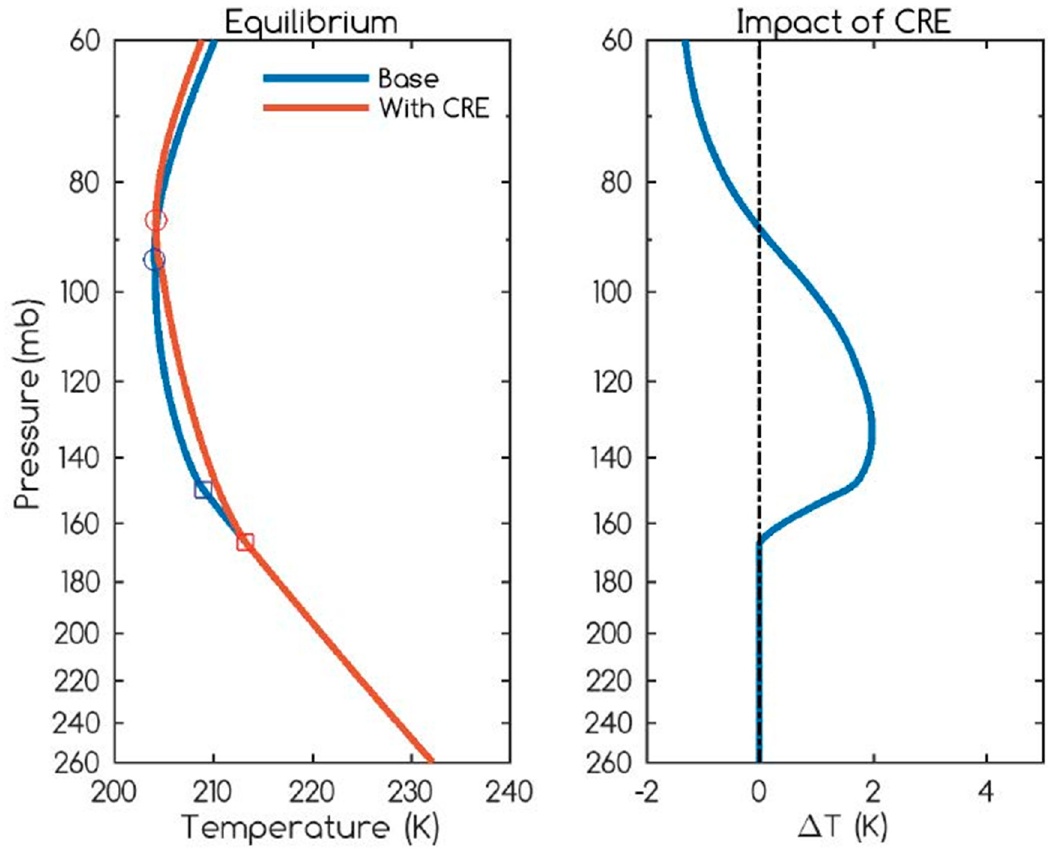
Figure 5. ( Left ) Equilibrium temperature profiles from the radiative–convective model with (red) and without (blue) cloud radiative effects over the tropics (20° N–20° S). The square symbols indicate the top of convection. Circles indicate the cold point. ( Right ) Impact of CRE at the equilibrium temperature.